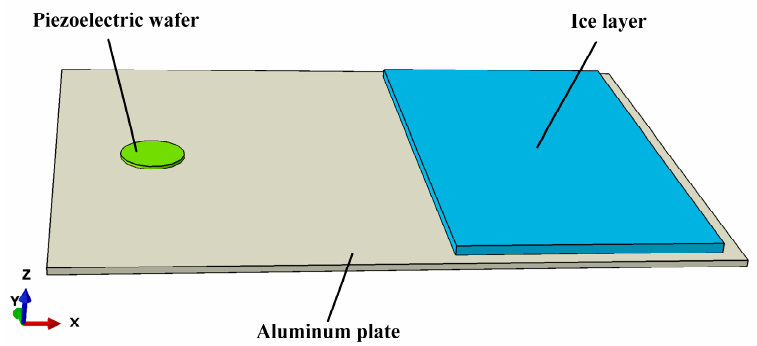
Figure 2. The 3D model of finite element simulation.